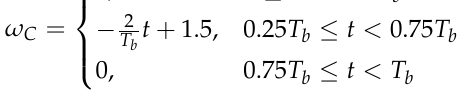
Figure 10. Distances between 𝑍𝑀𝑃 0 and the support lines ( 𝑑 𝐶 and 𝑑 𝐿 ).